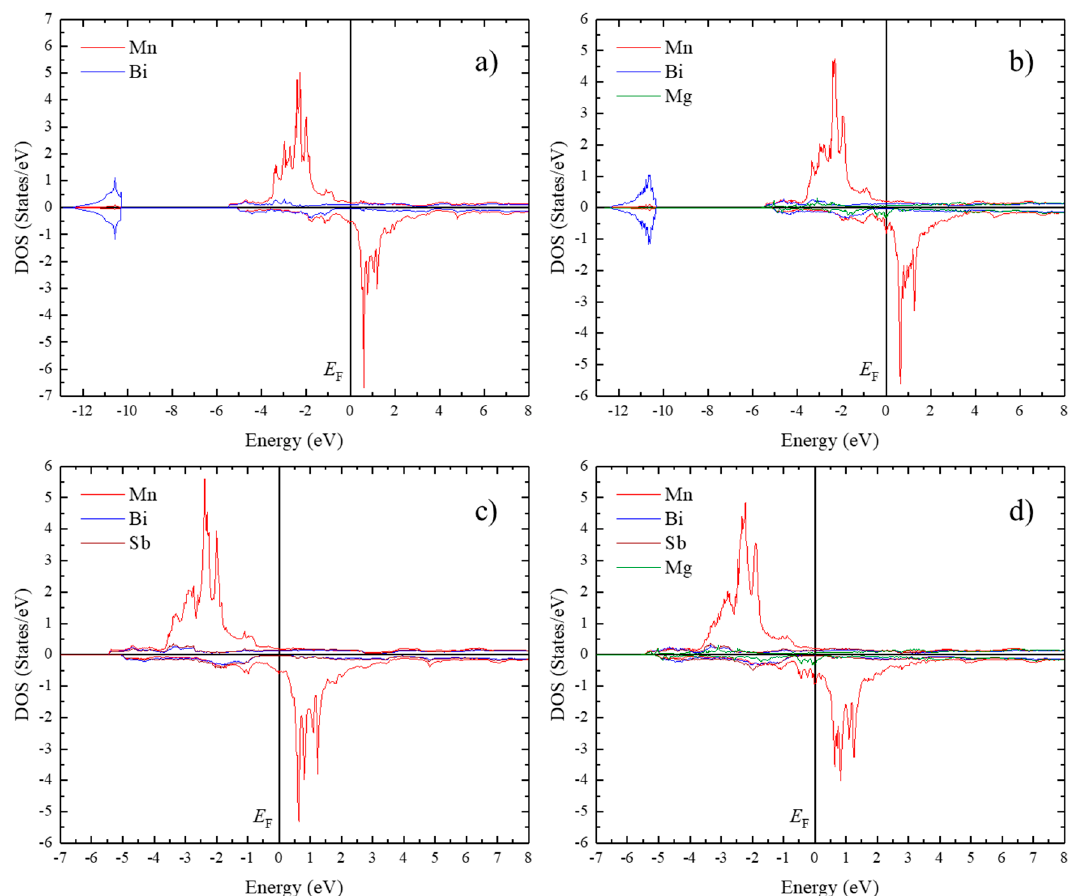
Figure 10. Density of states (DOS) for ( a ) MnBi, ( b ) Mn 16 Bi 15 Mg, ( c ) Mn 16 Bi 15 Sb, and ( d ) Mn 16 Bi 14 SbMg.